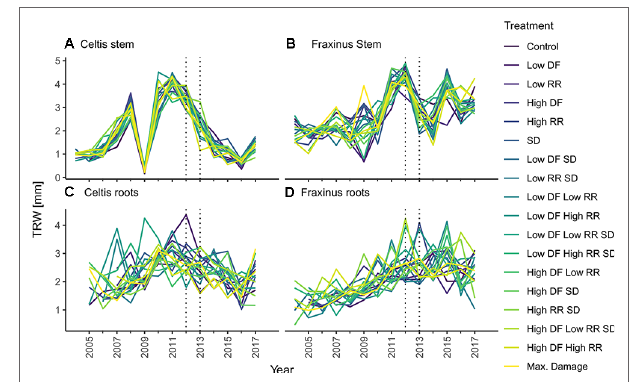
FIGURE 3 | Tree-ring chronologies of (A) Celtis stem growth, (C) Celtis average root growth, and (B) Fraxinus stem growth, and (D) Fraxinus average root growth for each combination of damage treatments. Low growth in 2009 for Celtis and 2009 and 2010 for Fraxinus is related to replanting operations. Damage treatments were applied in 2012–2013 as indicated by the two vertical dotted lines. Damage treatment levels are described as follows: DF, defoliation; RR, root reduction and SD, stem damage indicated as low = 37% damage and high = 75%